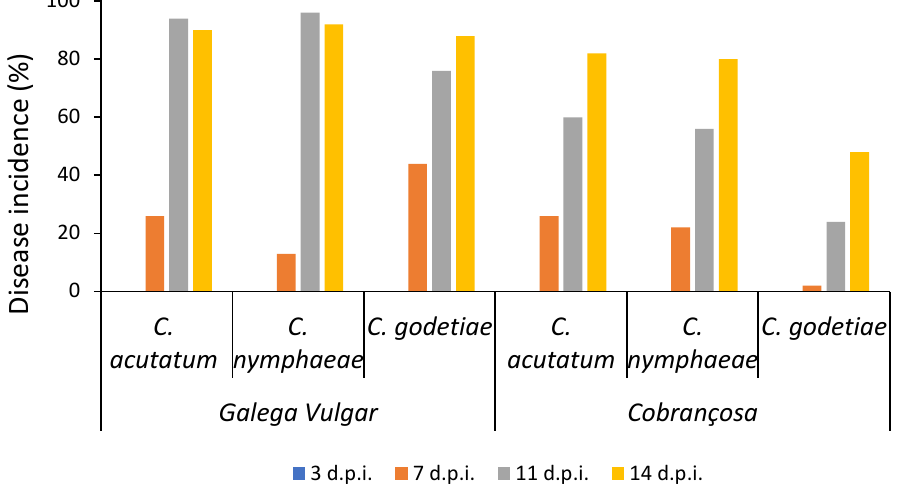
Figure 1. Evolution of anthracnose disease (% of fruits with symptoms) of Galega and Cobrançosa fruits, after 3, 7, 11, and 14 days post-inoculation (d.p.i.) with Colletotrichum acutatum , C. nymphaeae, and C. godetiae.